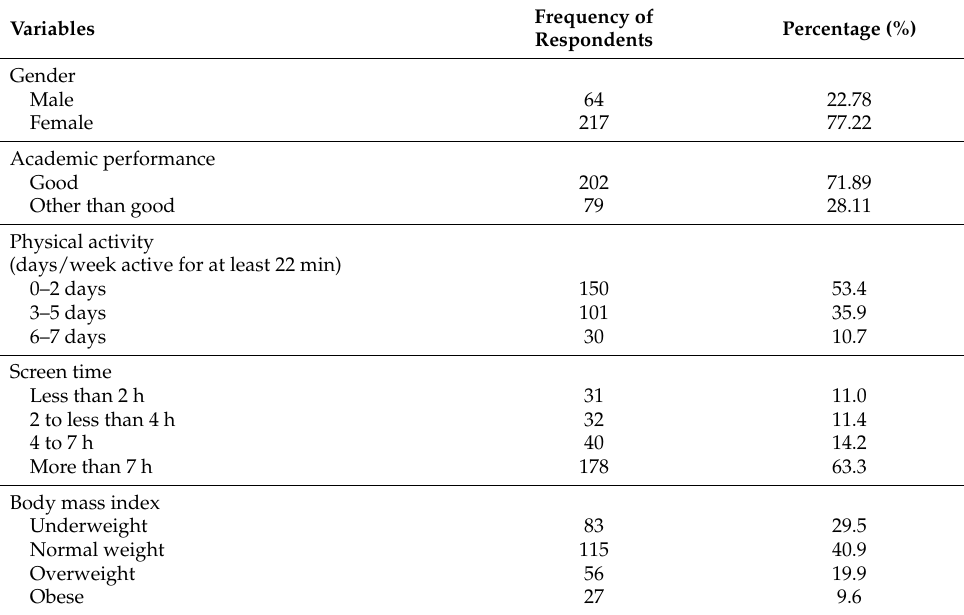
Table 2. Descriptive Statistics of Categorical